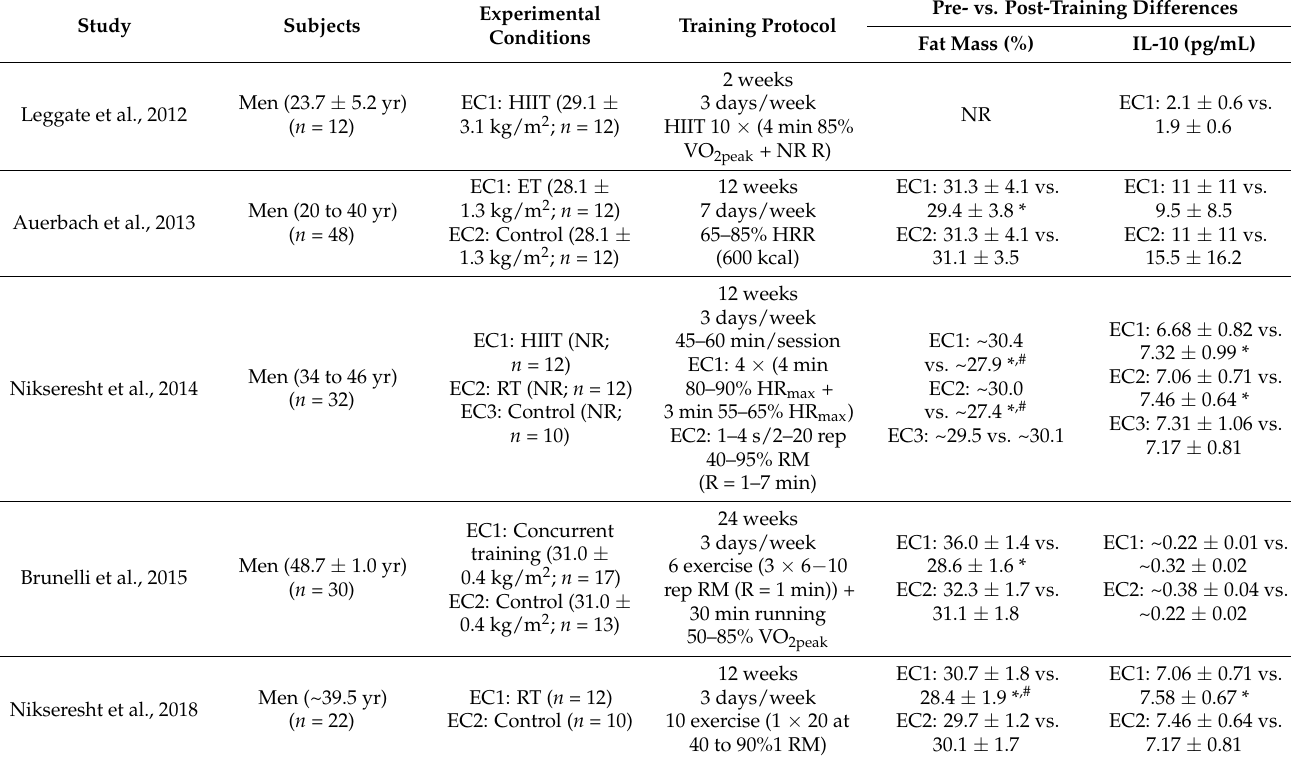
Pre- vs. Post-Training Differences Experimental Training Protocol Conditions Fat Mass (%) IL-10 (pg/mL)